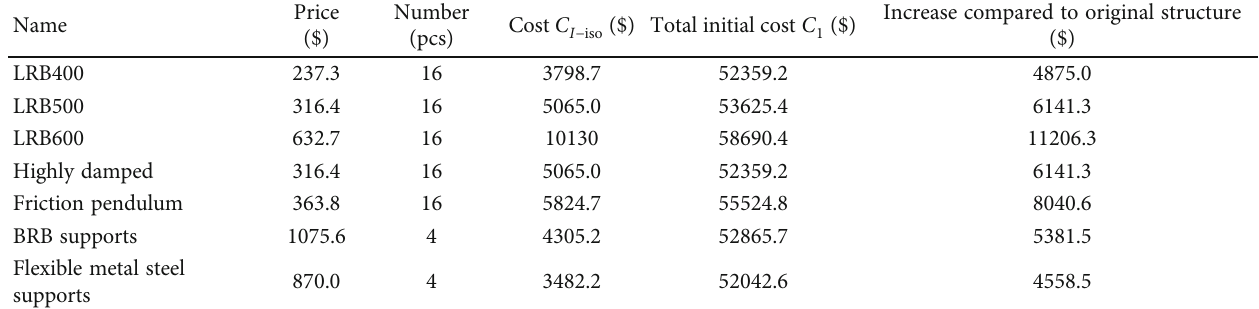
Table 6: Direct construction costs for each structure.